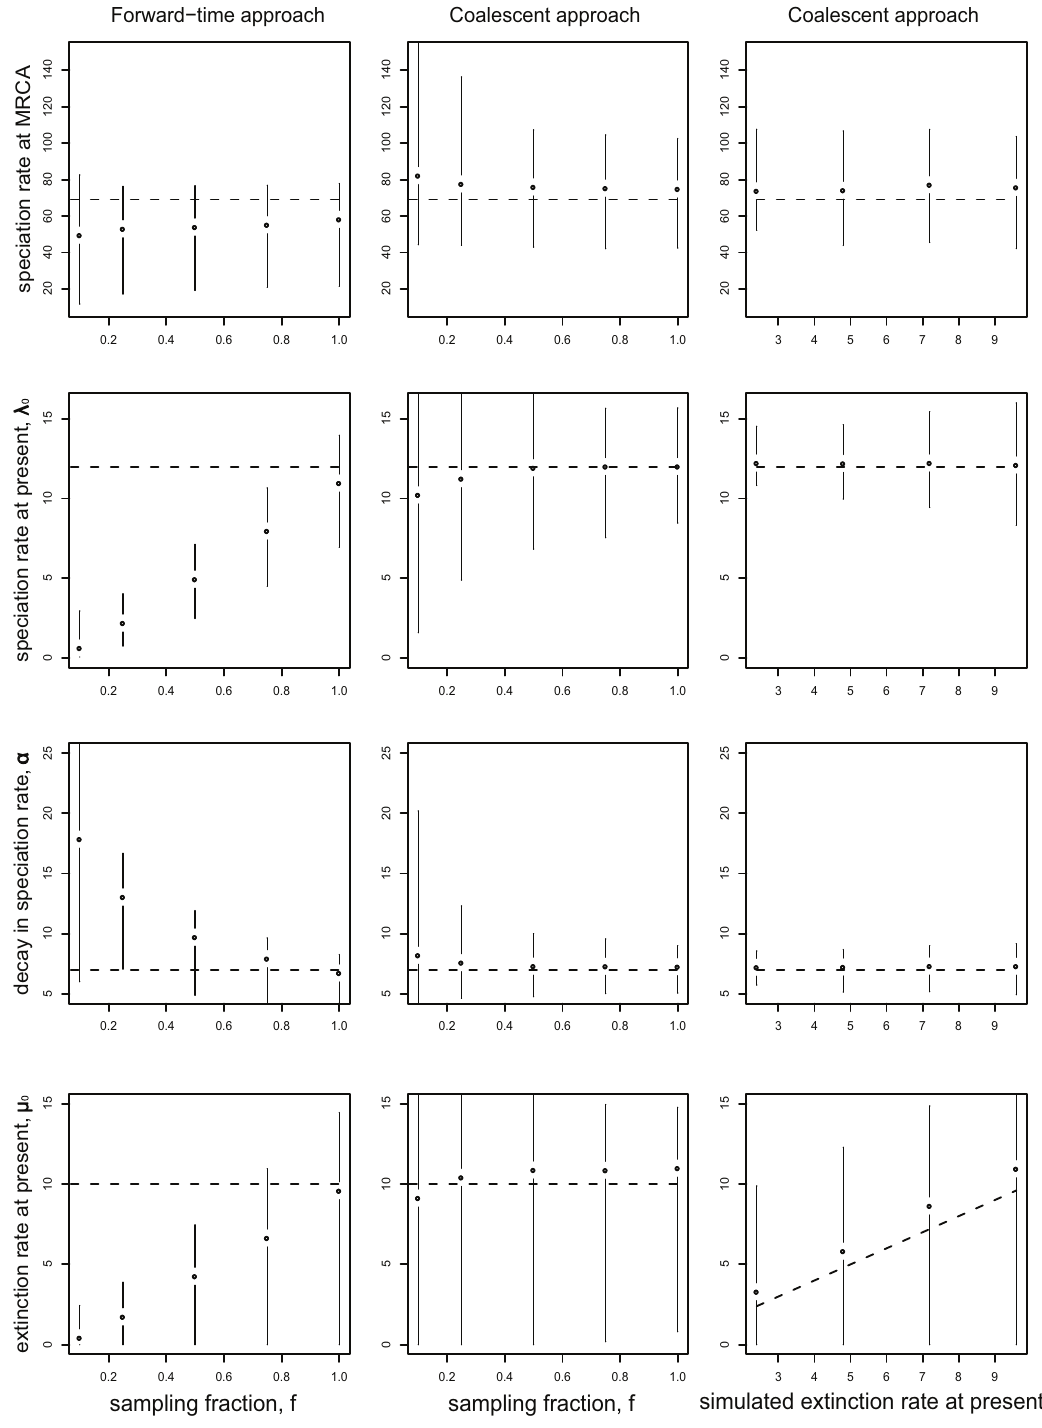
Figure 3. The coalescent method provides robust estimates of diversification rates from incompletely sampled phylogenies. The figure shows maximum likelihood parameter estimates for phylogenies simulated under Model 4a (extinction rate is constant over time and speciation rate decays exponentially). The true, simulated parameters of diversification are indicated by dashed lines (expressed in number of events per time unit). Points and error bars indicate the median and 95% quantile range of the maximum likelihood parameter estimates, across 1,000 simulated phylogenies for each parameter set. The right column shows the estimated extinction rate at present, compared to its true, simulated value. Before estimating parameters, species were randomly sampled from the simulated phylogenies. In the left and middle columns the sampling fraction f ranged from 10% of species (poorly sampled) to 100% of species (fully sampled). In the right column, f =75% of species were sampled. MRCA, time at the most recent common